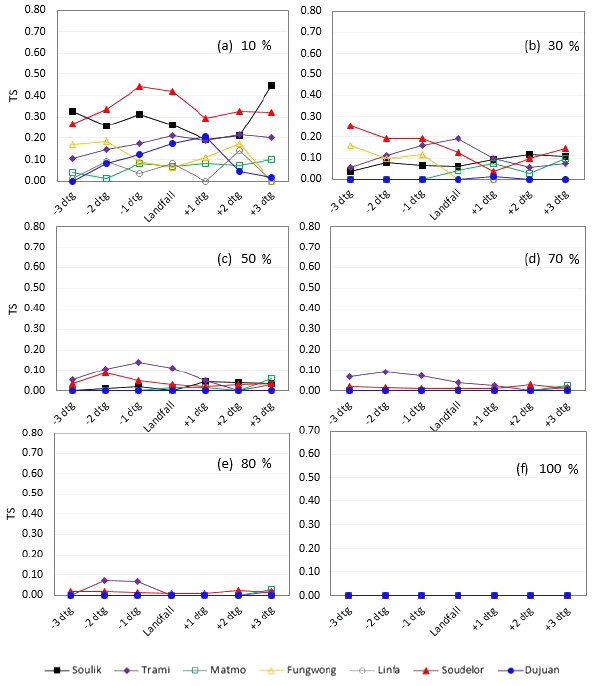
Figure 9. Comparisons of TS performance with a 49 to 72h lead time considering various probability thresholds without a data as- similation